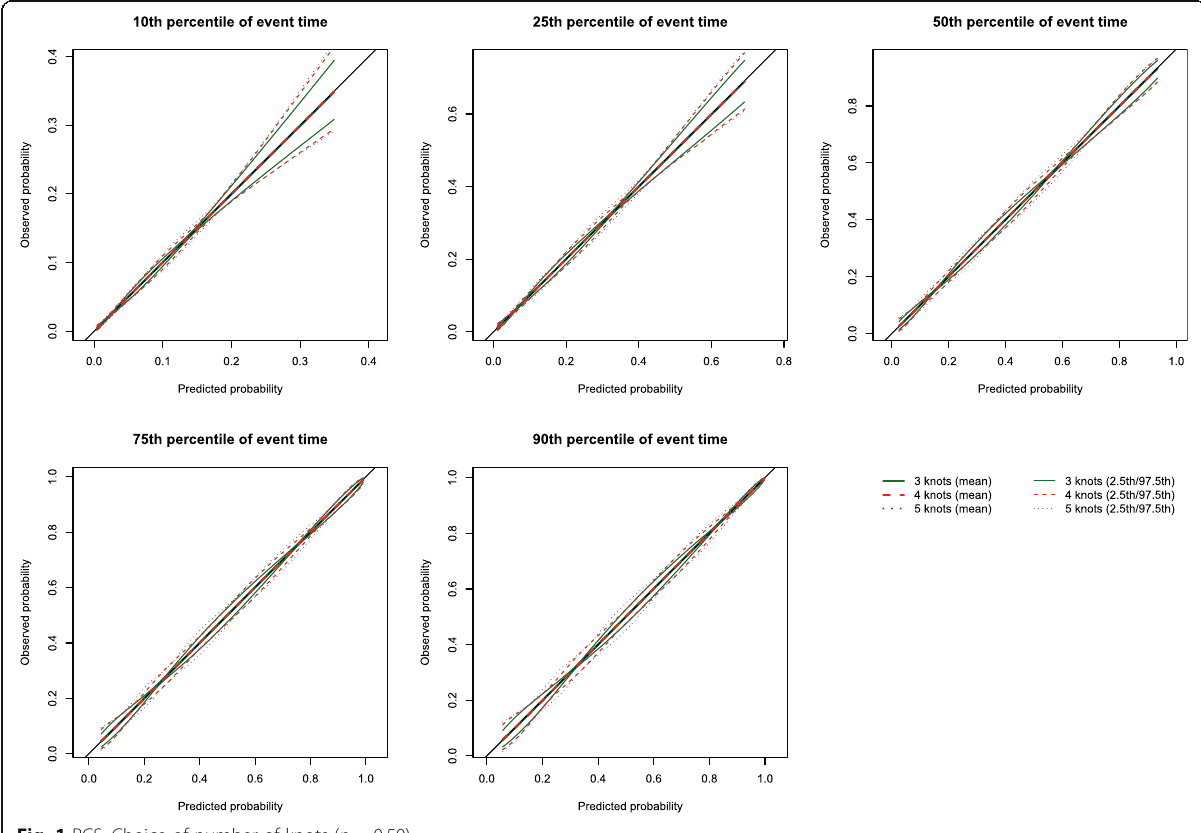
Fig. 1 RCS: Choice of number of knots ( p =